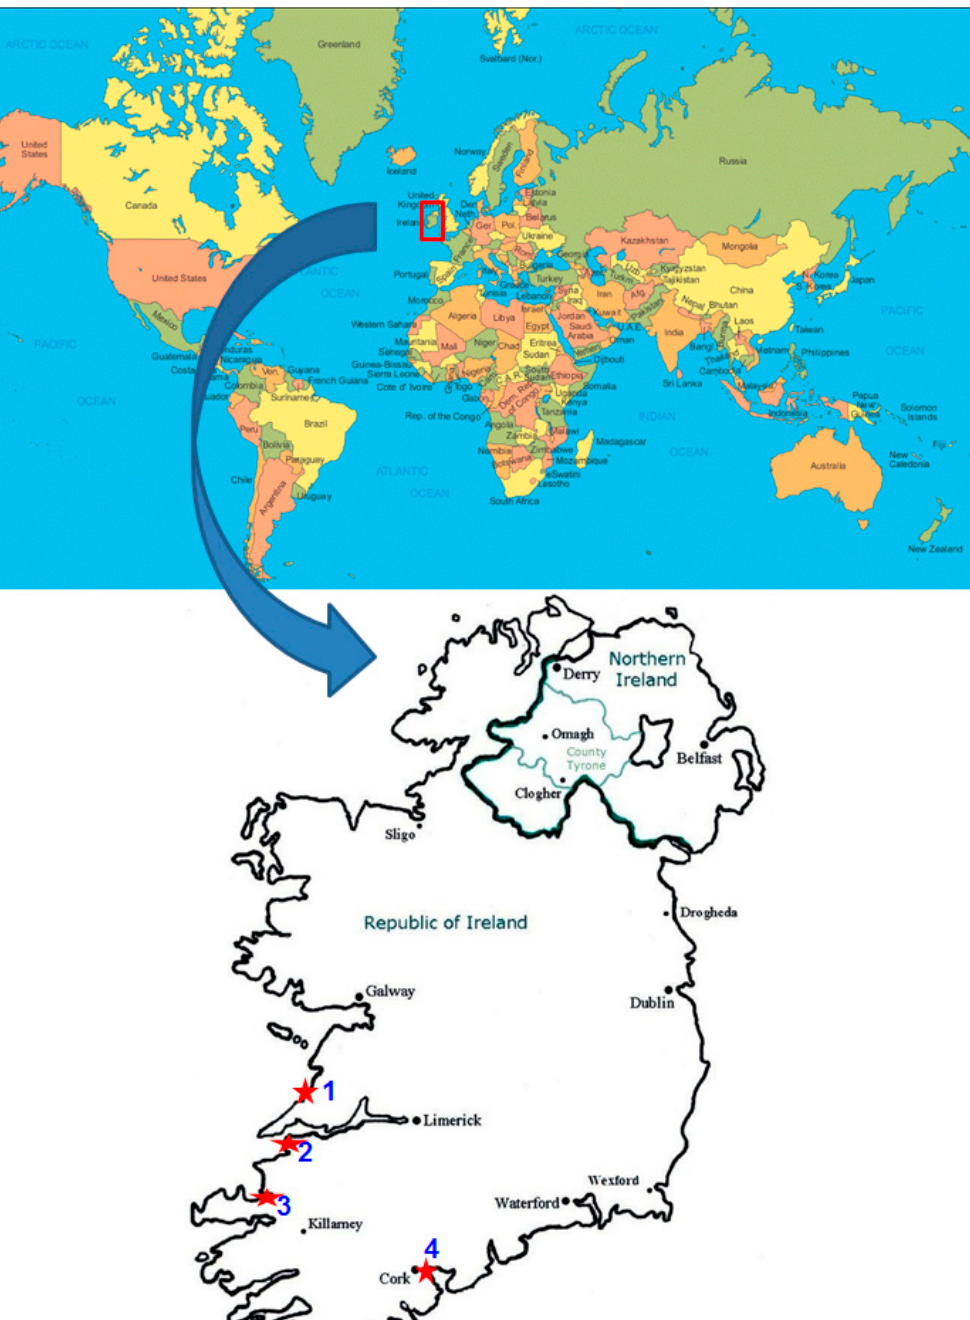
Figure 1. Map showing sampling sites of Irish coastal areas. 1, Kilkee; 2, Ballybunion; 3, Tralee; and 4, Cork.